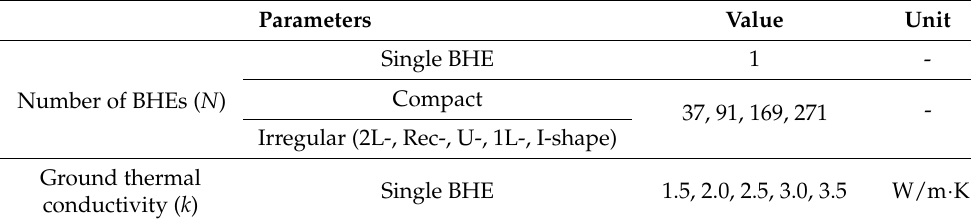
Table 2. Simulation cases.